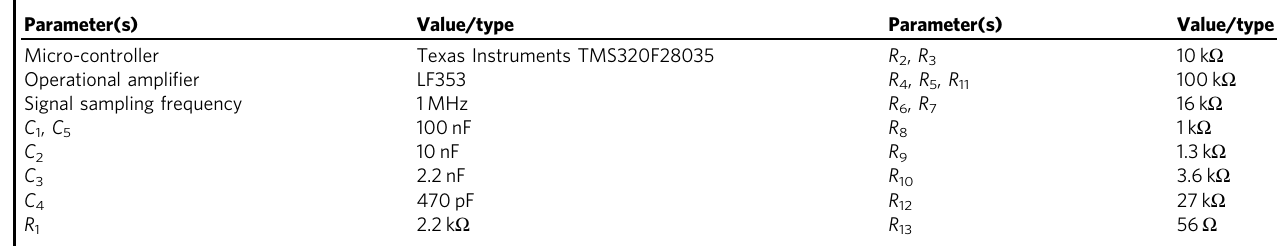
Table 2 Experimental receiver parameters for the conventional buck/boost